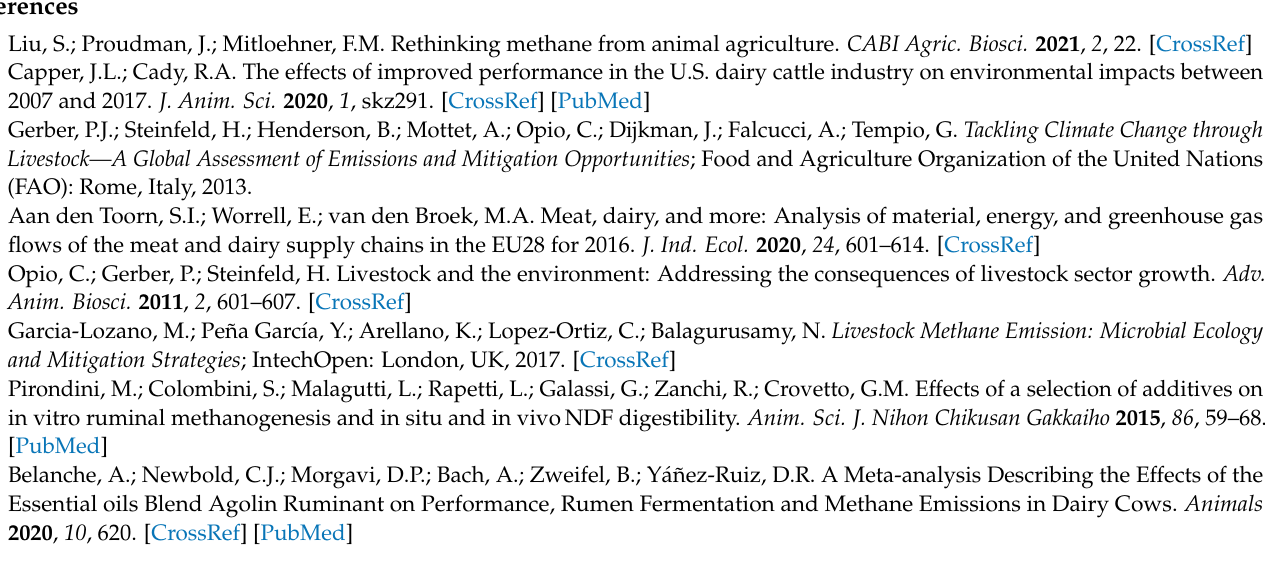
Figure S2: Analysis of the composition of the Control and Treatment feces, done with the portable NIR instrument Polispec, during the